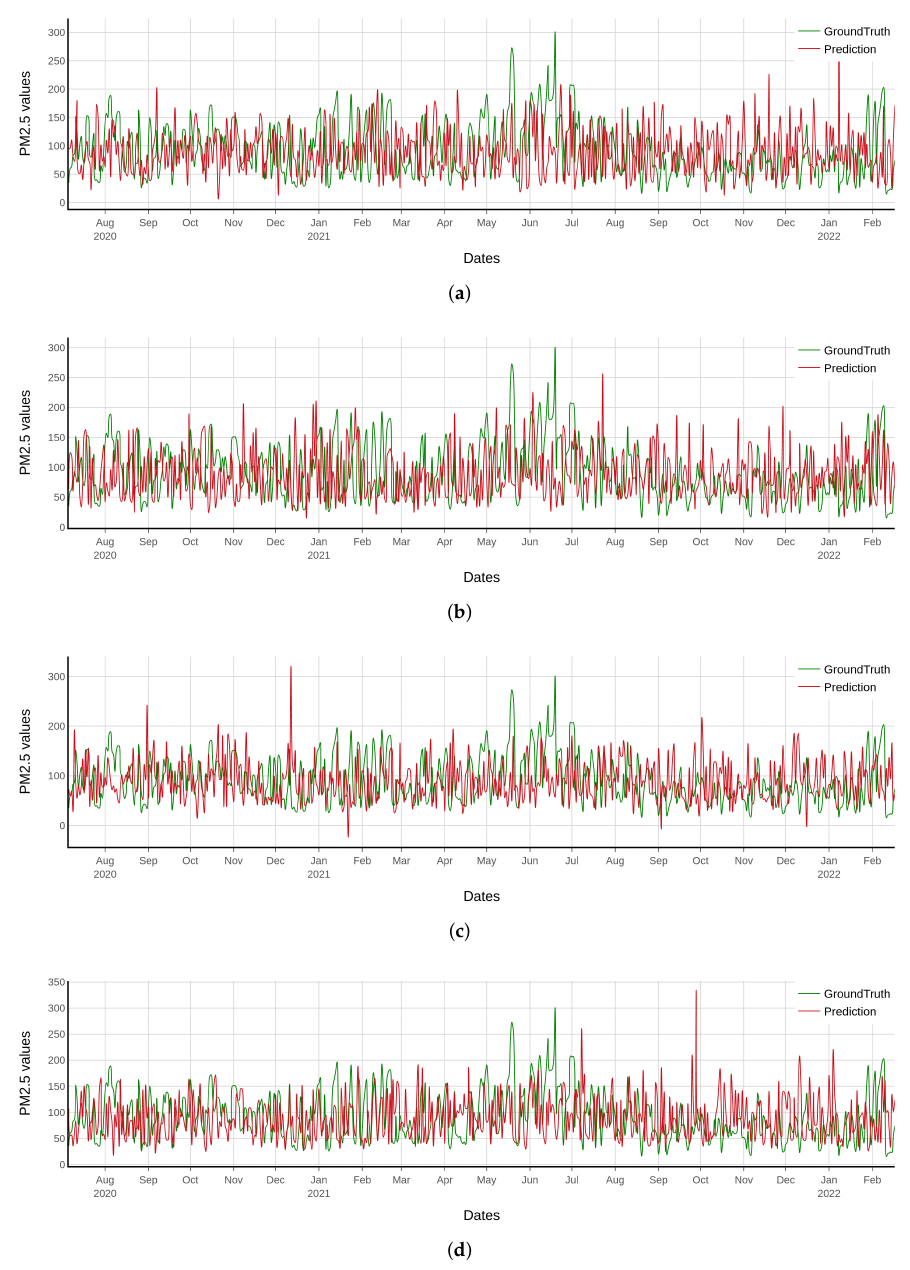
Figure 6. Beijing PM25 predictions. ( a ) PM2.5 predictions on the testing set using Informer; ( b ) PM2.5 predictions on the testing set using InformerStack; ( c ) PM2.5 predictions on the testing set using ResInformer; ( d ) PM2.5 predictions on the testing set using